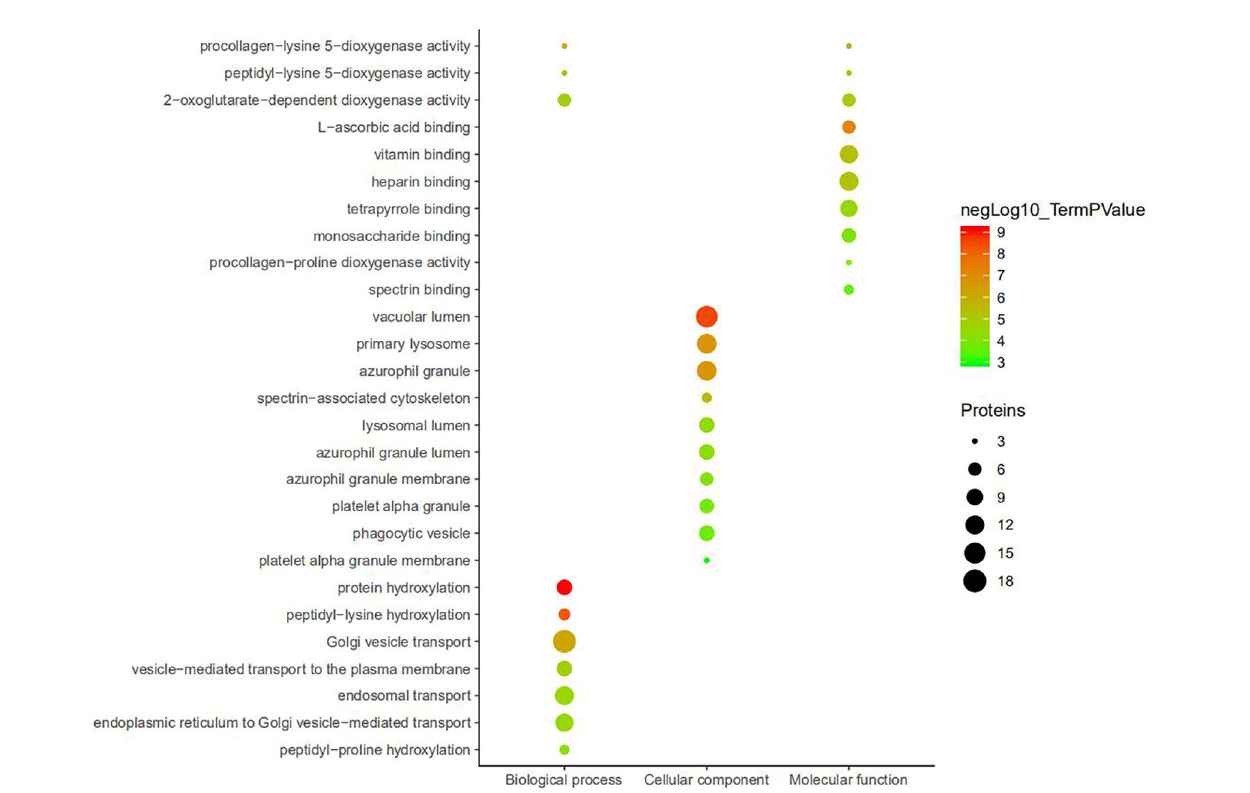
FIGURE 4 | Top 10 GO enrichment analysis of DEPs. Function of the DEGs in tissues is described according to its GO characteristics (Biological process, Molecular function, Cell components). -Log10 (p. adj.value) < 0.05 and count of gene is > =